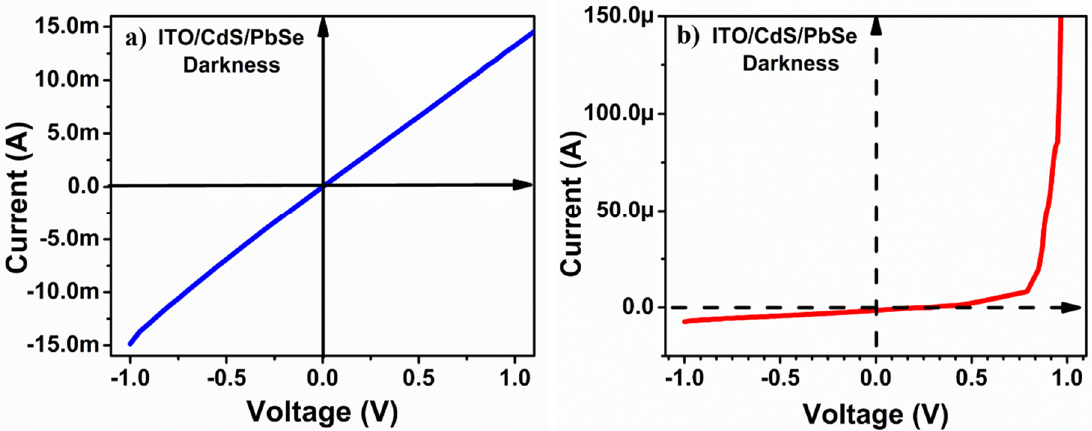
Figure 7. I vs. V characterization under darkness conditions for the ITO/CdS/PbSe heterostructure: ( a ) ohmic response (without annealing); and ( b ) diode response (annealing at 150 °C at 5 min).